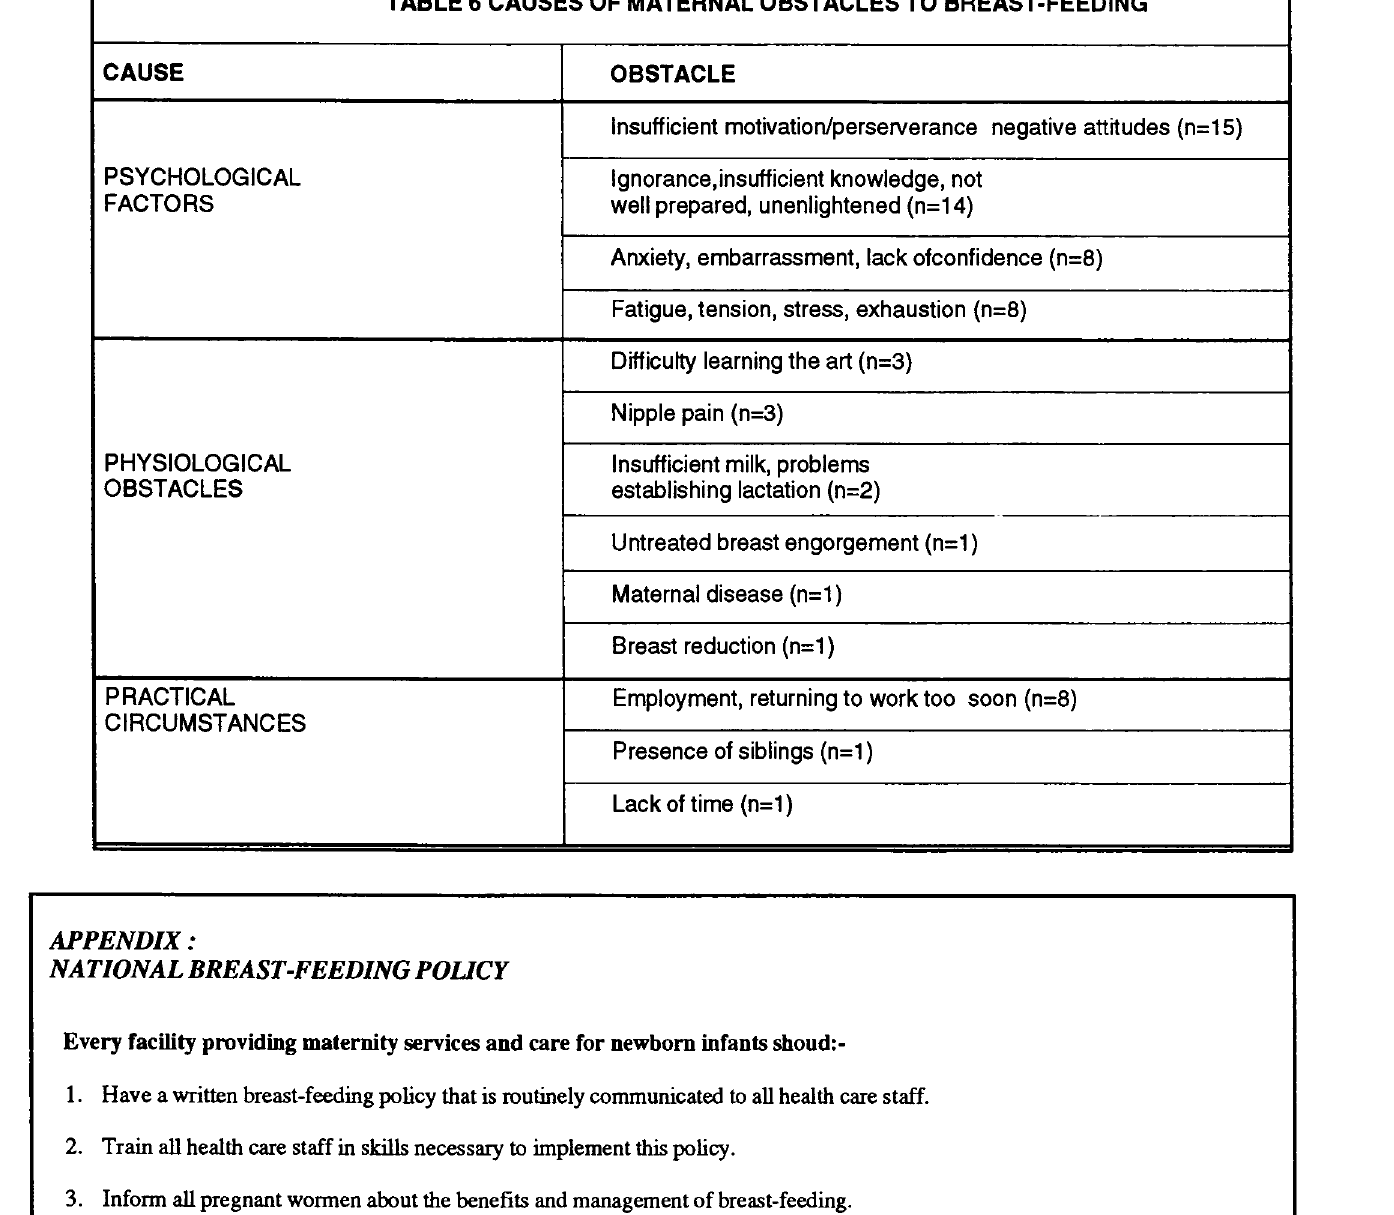
TABLE 6 CAUSES OF MATERNAL OBSTACLES TO